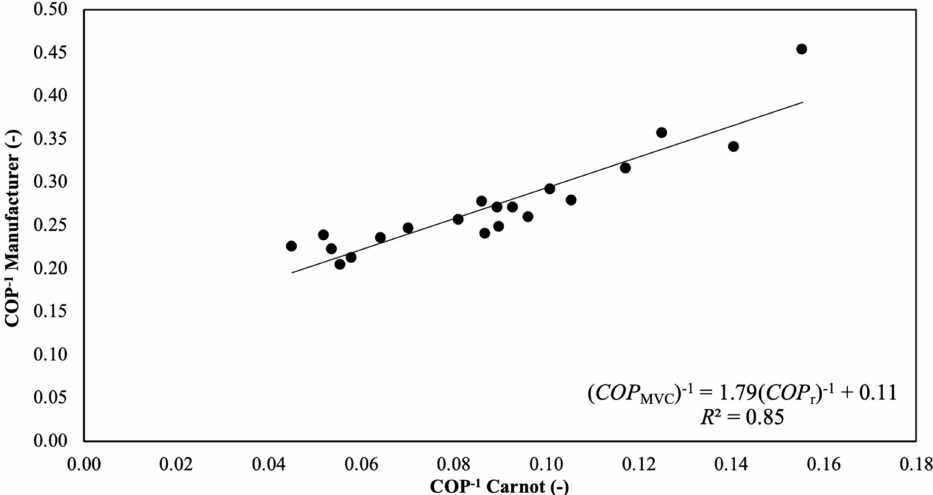
Figure 6. COP of 20 commercial MVC heat pumps from manufacturer datasheets as a function of Carnot COP. The range of theoretical Carnot e ffi ciencies corresponds to temperature lifts up to 80 ◦ C (based on a heat-source temperature of 100 ◦